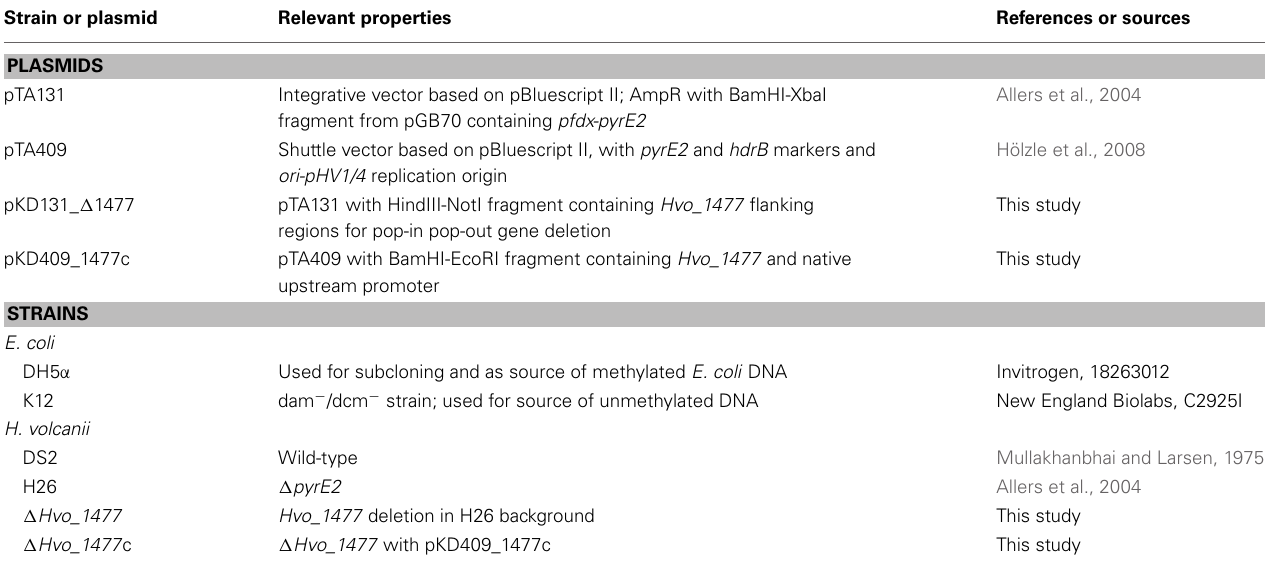
Table 1 | Strains and